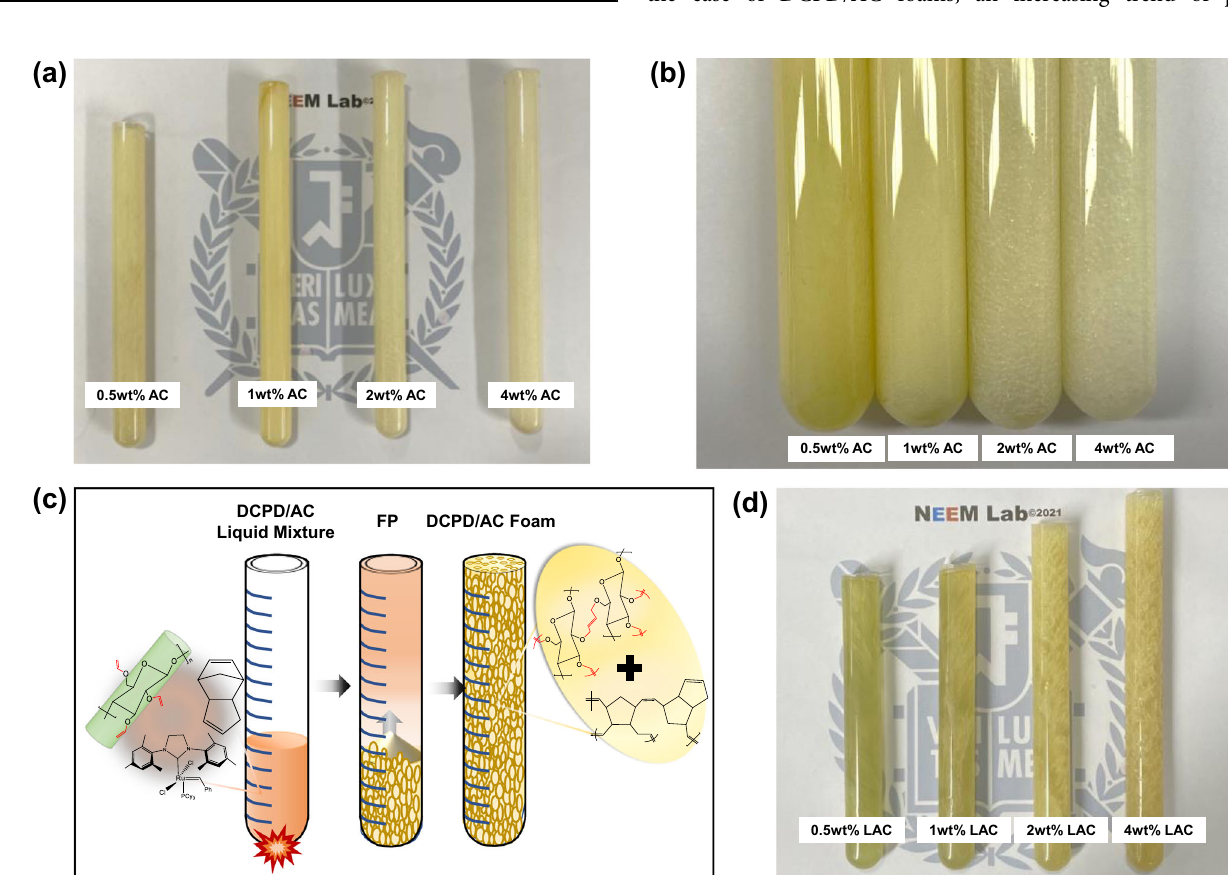
Fig. 2 FP-mediated production of DCPD/AC, -LAC foams. a Image of frontally polymerized DCPD/AC foams at varying AC wt%. b Pore sizes of DCPD/ AC foams increased with increasing AC wt%. c A schematic showing the frontal manufacturing of DCPD/AC foams. d Image of DCPD/LAC foam that were produced under the same experimental set up as the DCPD/AC foams.